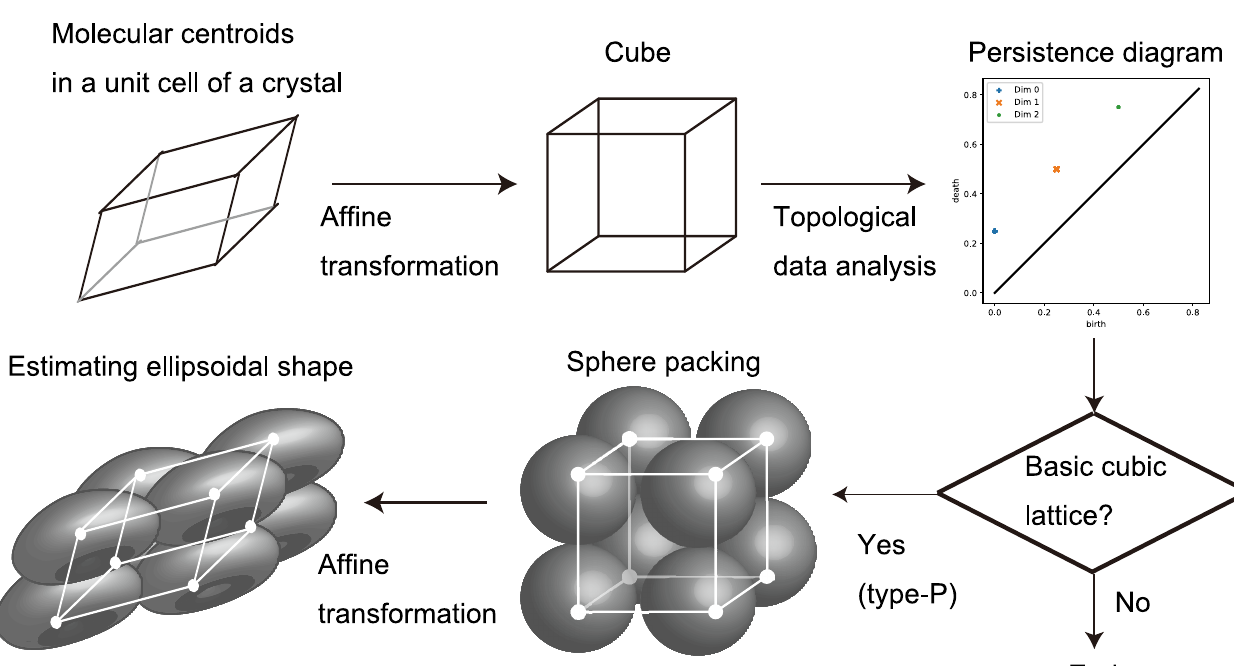
Fig 1. Methodology overview. An overview of the method to estimate the shapes of ellipsoids packed in molecular crystals is illustrated. This is an example for an organic molecular crystal where the molecular arrangement corresponds to the primitive (type-P) lattice (see Figs 2(a) and 4(a) for details).